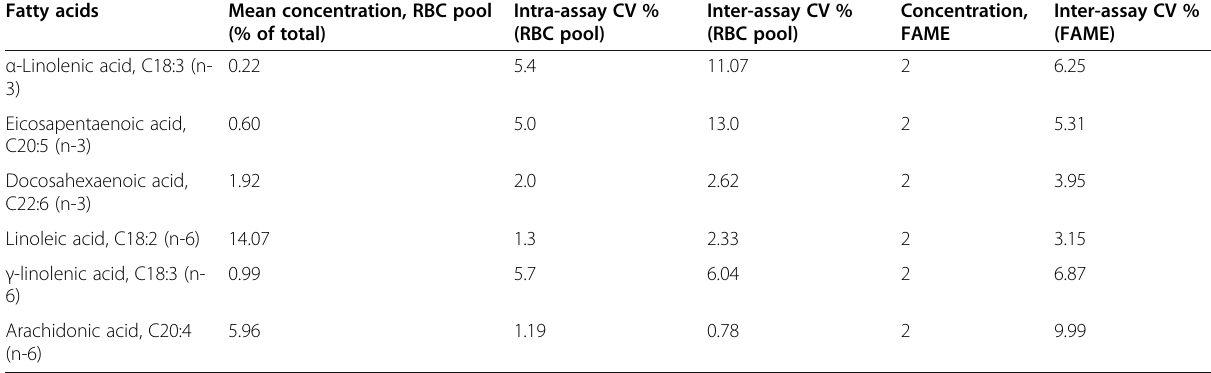
CV, coefficient of variation; FAME, fatty acid methyl ester; RBC, red blood